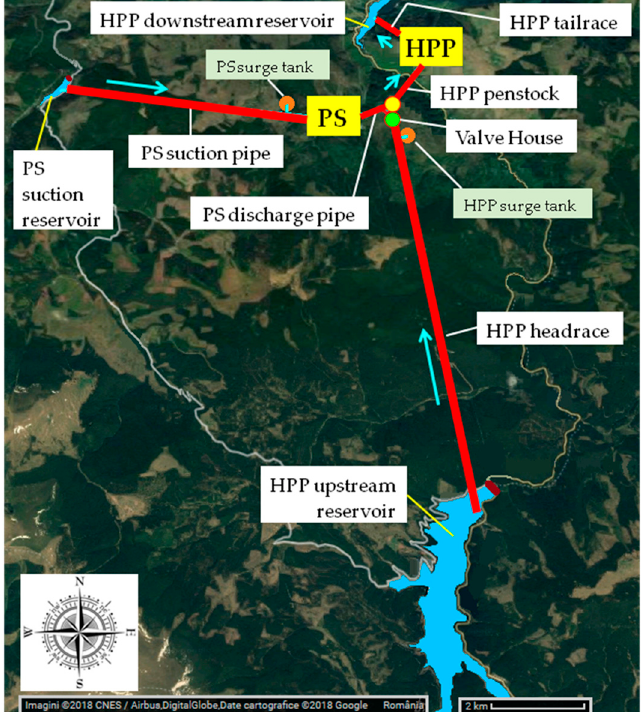
Figure 1. Hydropower facility scheme, superposed on the geographical map of the area: Gâlceag Hydro Power Plant (HPP) and Gâlceag Pumping Station